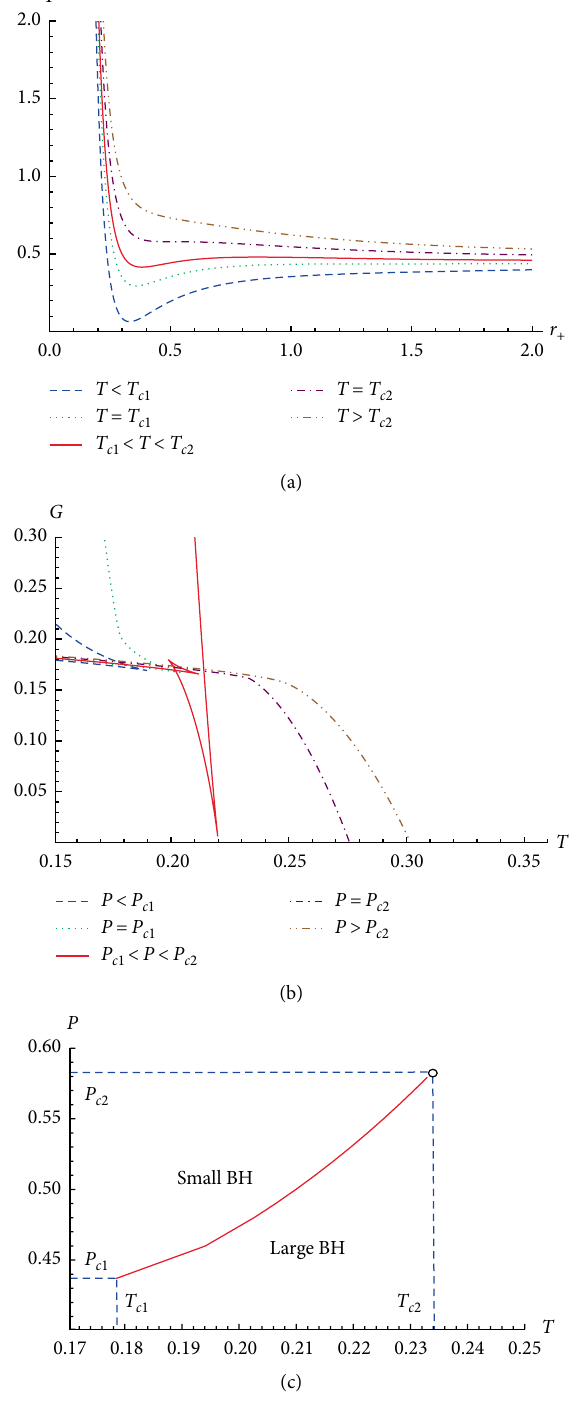
Figure 5: The 𝑃 − 𝑟 dimensional charged AdS black holes with 휔 푄 = 0.2 , and 푁 happens in the region of 𝑇